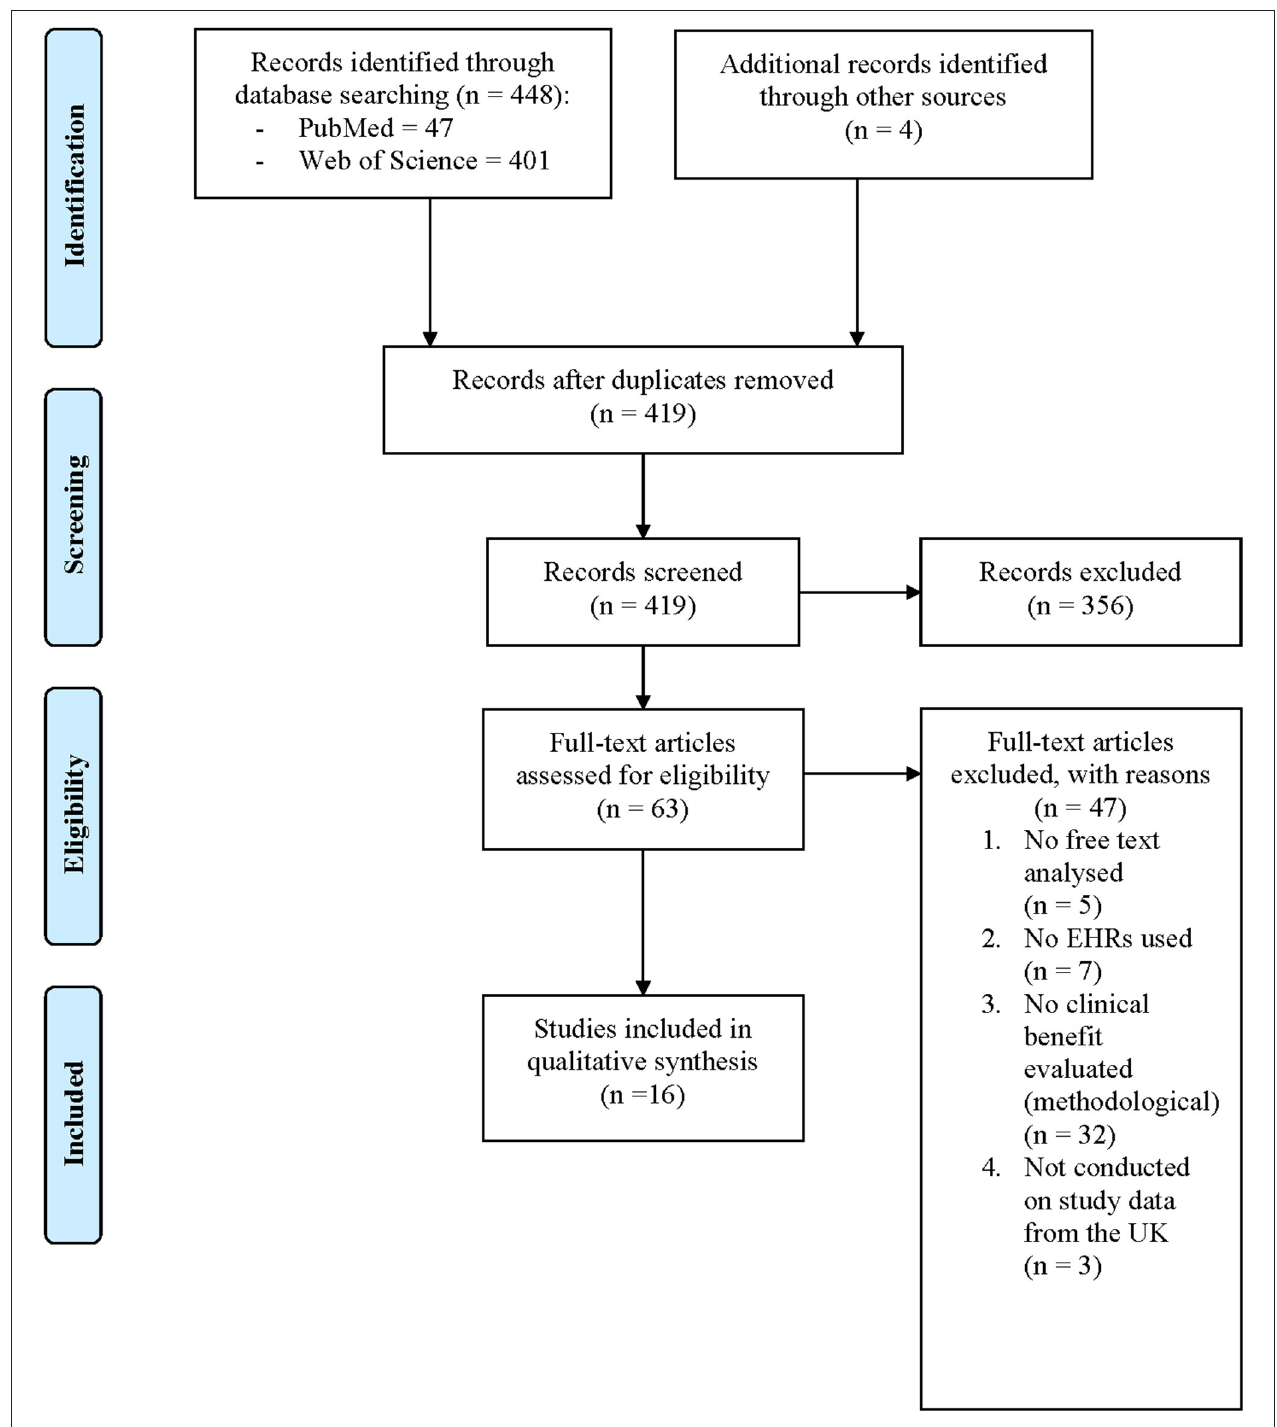
FIGURE 1 | PRISMA flow diagram showing search and screening